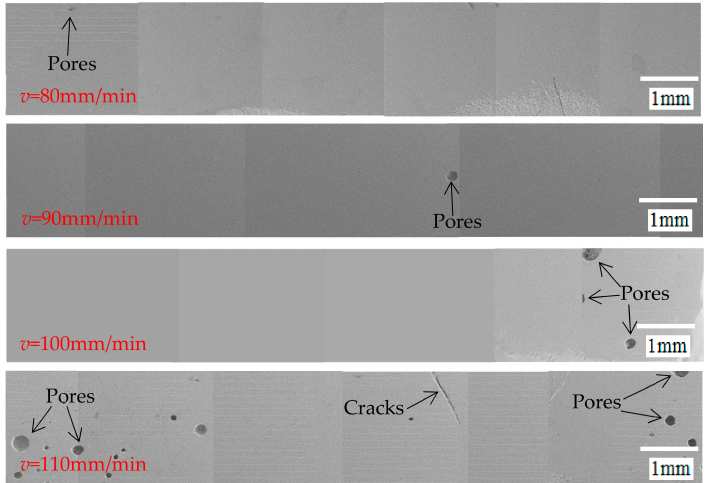
Figure 14. The distribution of pores at di ff erent welding speeds.